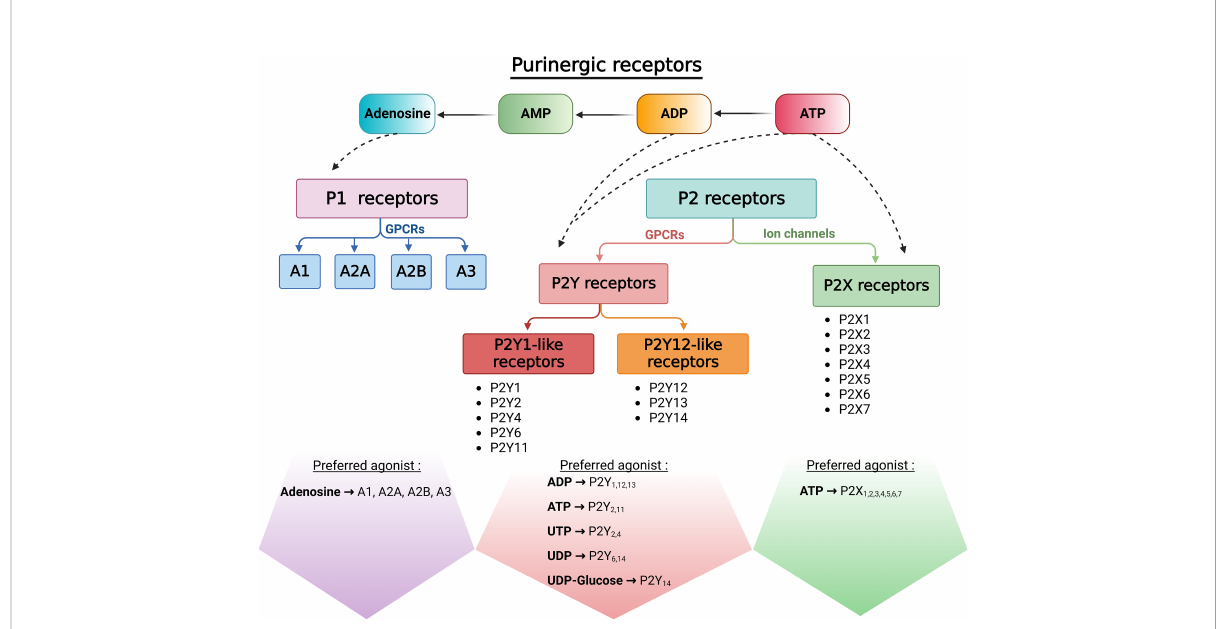
FIGURE 1 Classi fi cation of purinergic receptors. Once released into the extracellular space, ATP is rapidly hydrolyzed by ectonucleotidases to generate ADP, AMP, and adenosine. Adenosine activates P1 receptors, a family of G-protein coupled receptors (GPCRs). P2X receptors are non-selective cation channels that open in response to ATP by their only endogenous ligand. In addition to ATP and ADP, P2Y metabotropic receptors can mediate cellular responses to uracil nucleotides and nucleotides